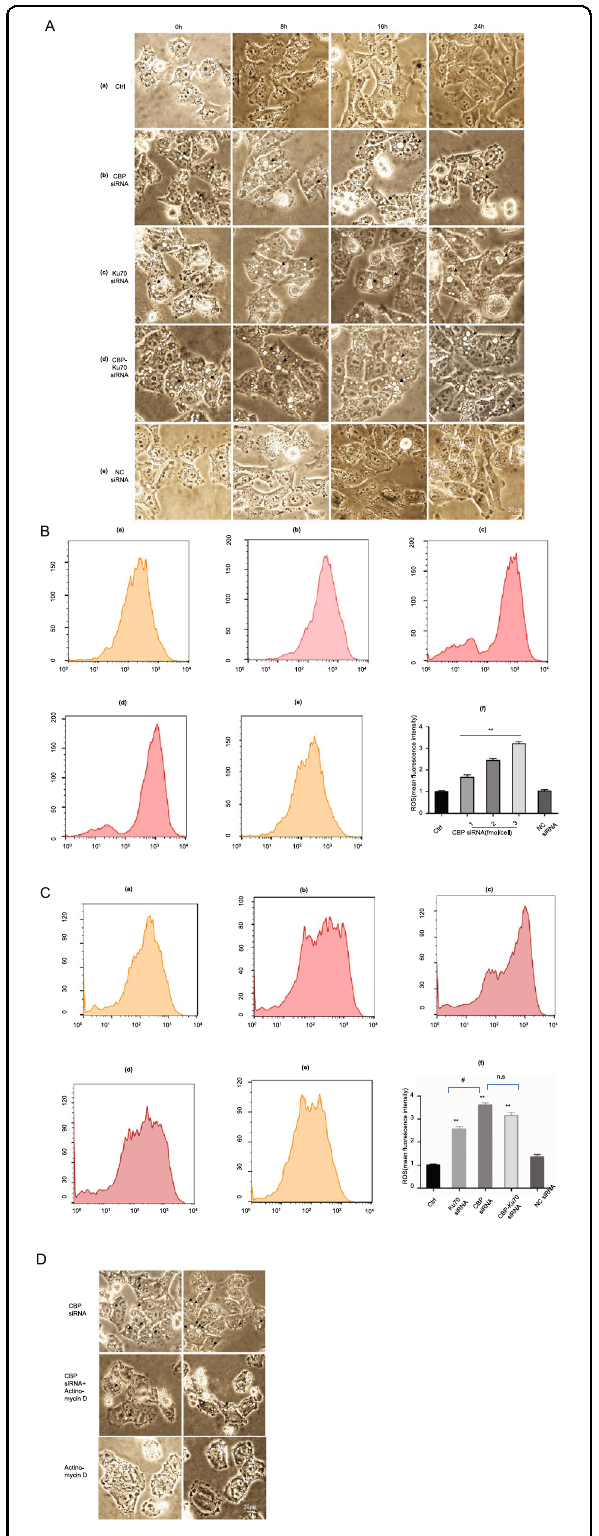
CBP mRNA and Nrf2 mRNA can be clearly seen, when ing either CBP mRNA or Nrf2 mRNA individually, sug-